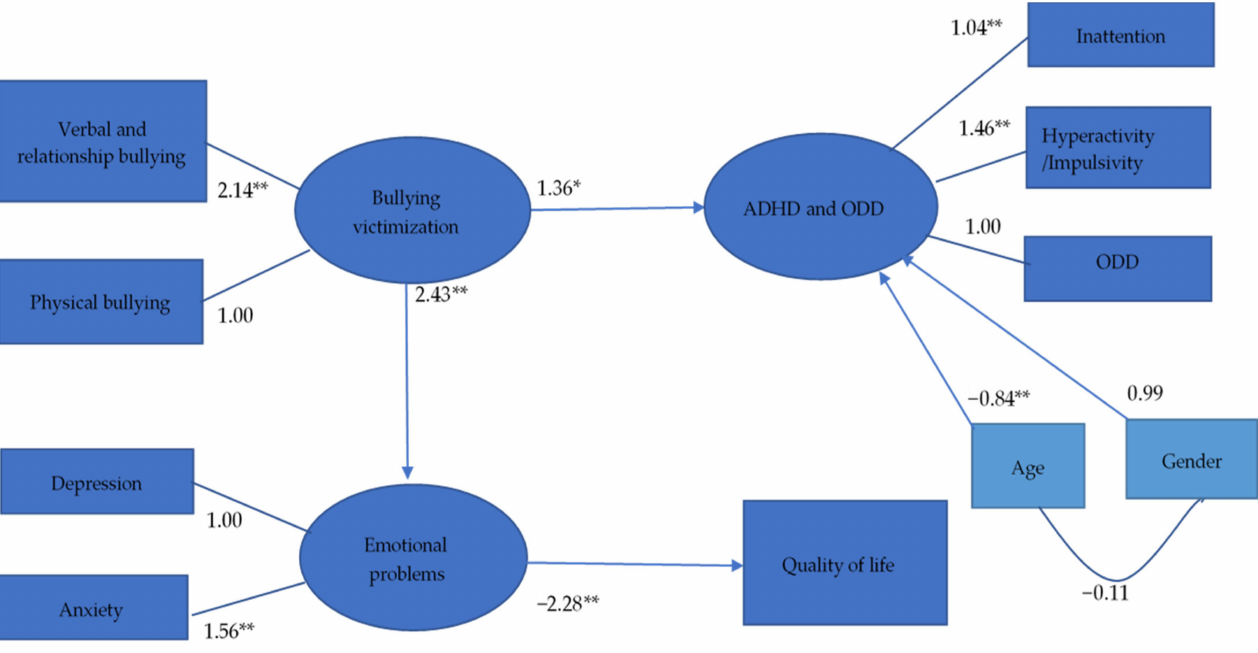
Figure 3. Standard coefficients in reduced model. ADHD: Attention-deficit/hyperactivity disorder; ODD: Oppositional defiant disorder. * p < 0.05; ** p <